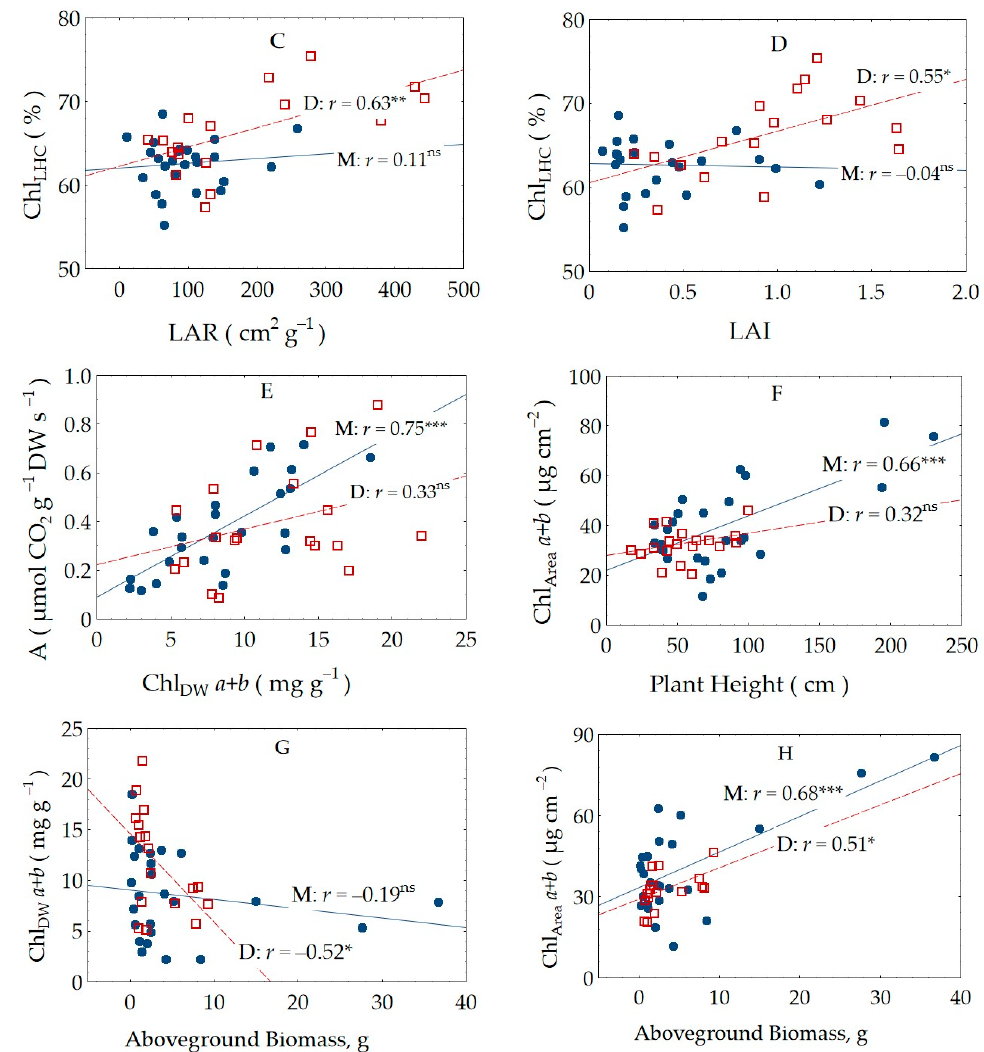
Figure 4. The relationship between ( A ) chlorophyll content per dry weight and LMA, ( B ) ratio of chlorophylls a and b and LMA, ( C ) proportion of chlorophyll in the light-harvesting complex and LAR, ( D ) proportion of chlorophyll in the light-harvesting complex and LAI, ( E ) chlorophyll content per dry weight and CO 2 uptake rate per dry weight, ( F ) chlorophyll content per area unit and plant height, ( G ) chlorophyll content per dry weight and aboveground biomass, and ( H ) chlorophyll content per area unit and aboveground biomass. D—red, empty squares and dotted line represent dicots; M—blue, filled circles and a solid line denote monocots. Significance of correlation coefficient r : ns , not significant; *, p < 0.05; **, p < 0.01; ***, p <